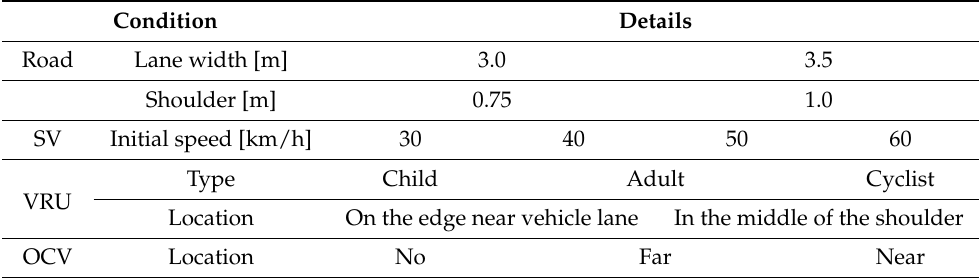
Table 1. Experimental conditions.